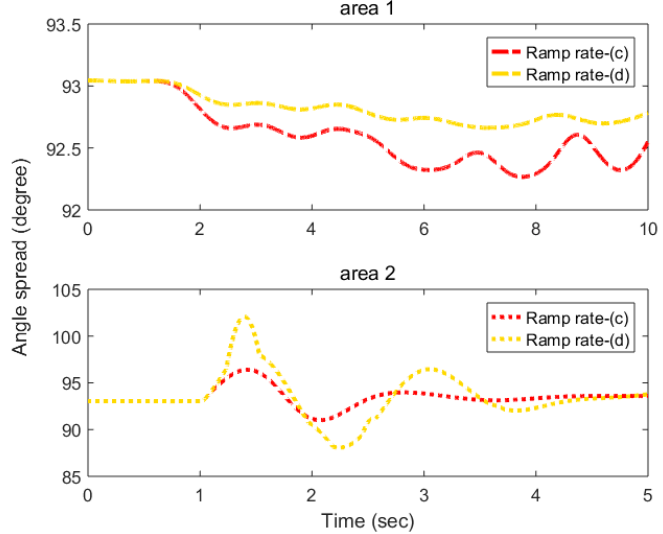
Figure 12. Angle spread results of each area according to (c) and (d) in Table 1.